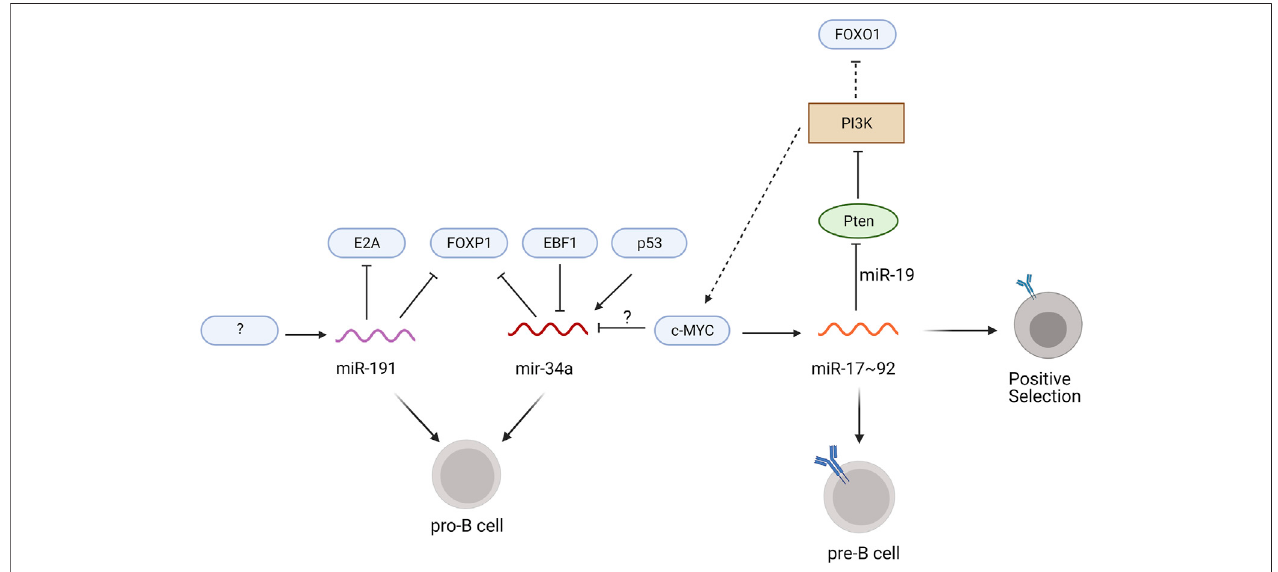
FIGURE 3 | miRNAs regulating pro-B to pre-B development. Transcription factors are indicated in blue ovals, the phosphoinositide kinase PI3K is shown as a brown box, the PTEN phosphatase is shown as a green oval, and miRNAs are colored wavy lines. Solid lines specify the direct regulation of mRNAs by the miRNA and dotted lines designate modulation of signaling pathways that alter the expression of the transcription factors. Unidenti fi ed regulators are indicated with question